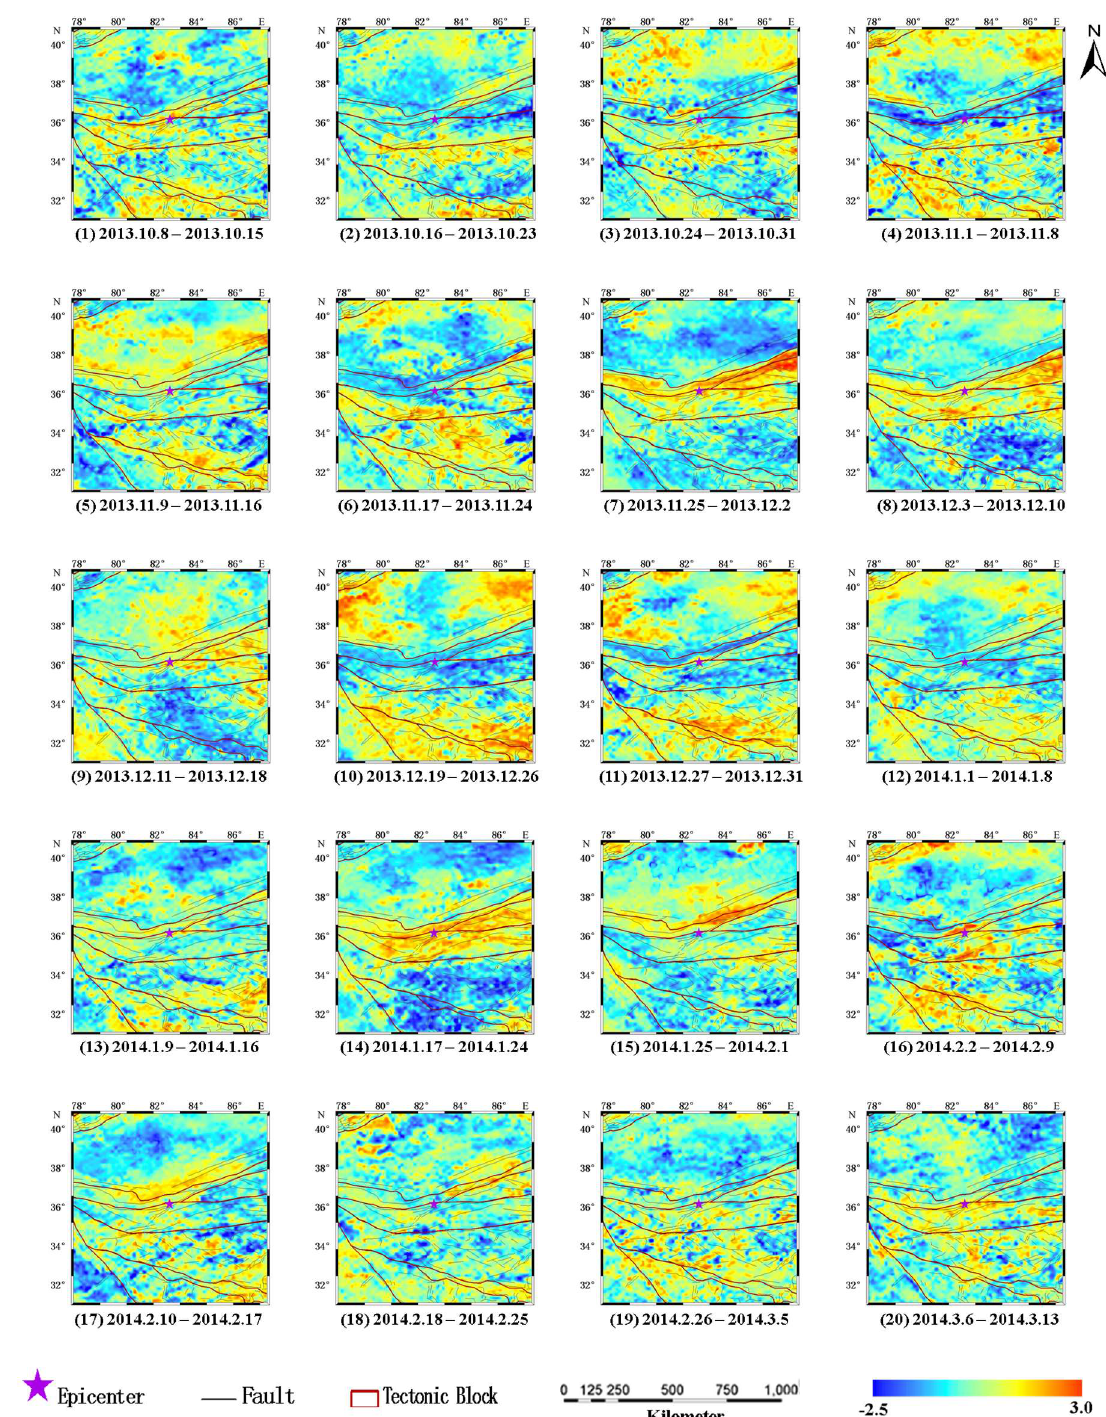
Figure 14. Spatio-temporal evolution of 𝐾 (cid:3047)(cid:3032)(cid:3030) extracted by the TTIA method in the Longmenshan fault region in unperturbed period. The pixels values in images are the mean values of 𝐾 (cid:3047)(cid:3032)(cid:3030) in the same time-slot of unperturbed periods.